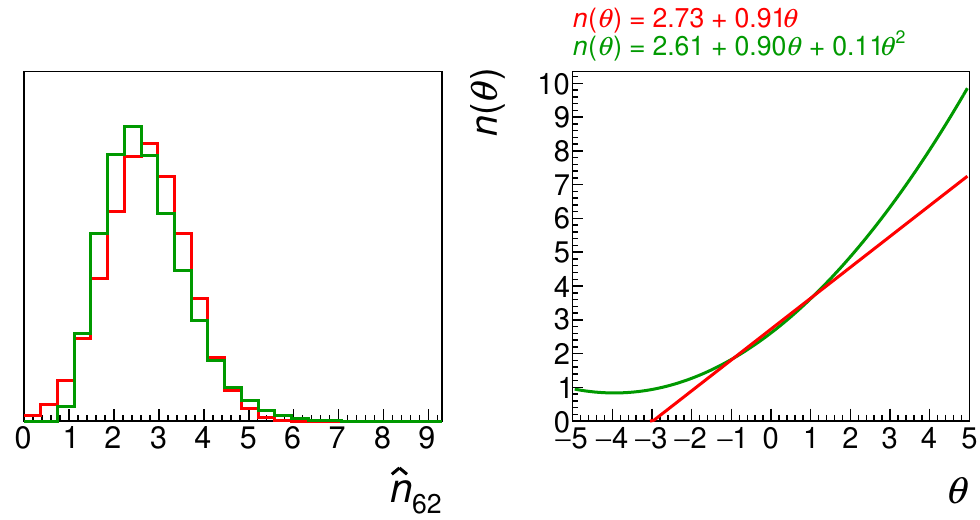
Figure 3 . Distributions of ^ n (green line), and when neglecting the third moment (red line), are shown in the right panel